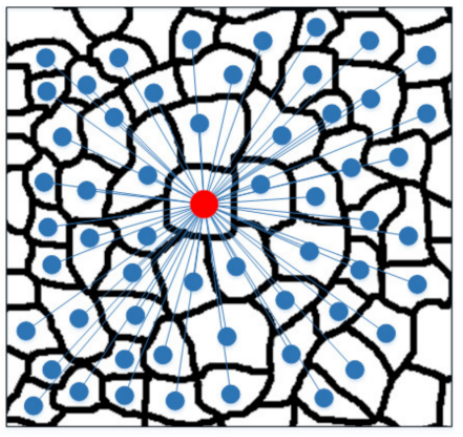
Figure 3. Schematic diagram of global graph